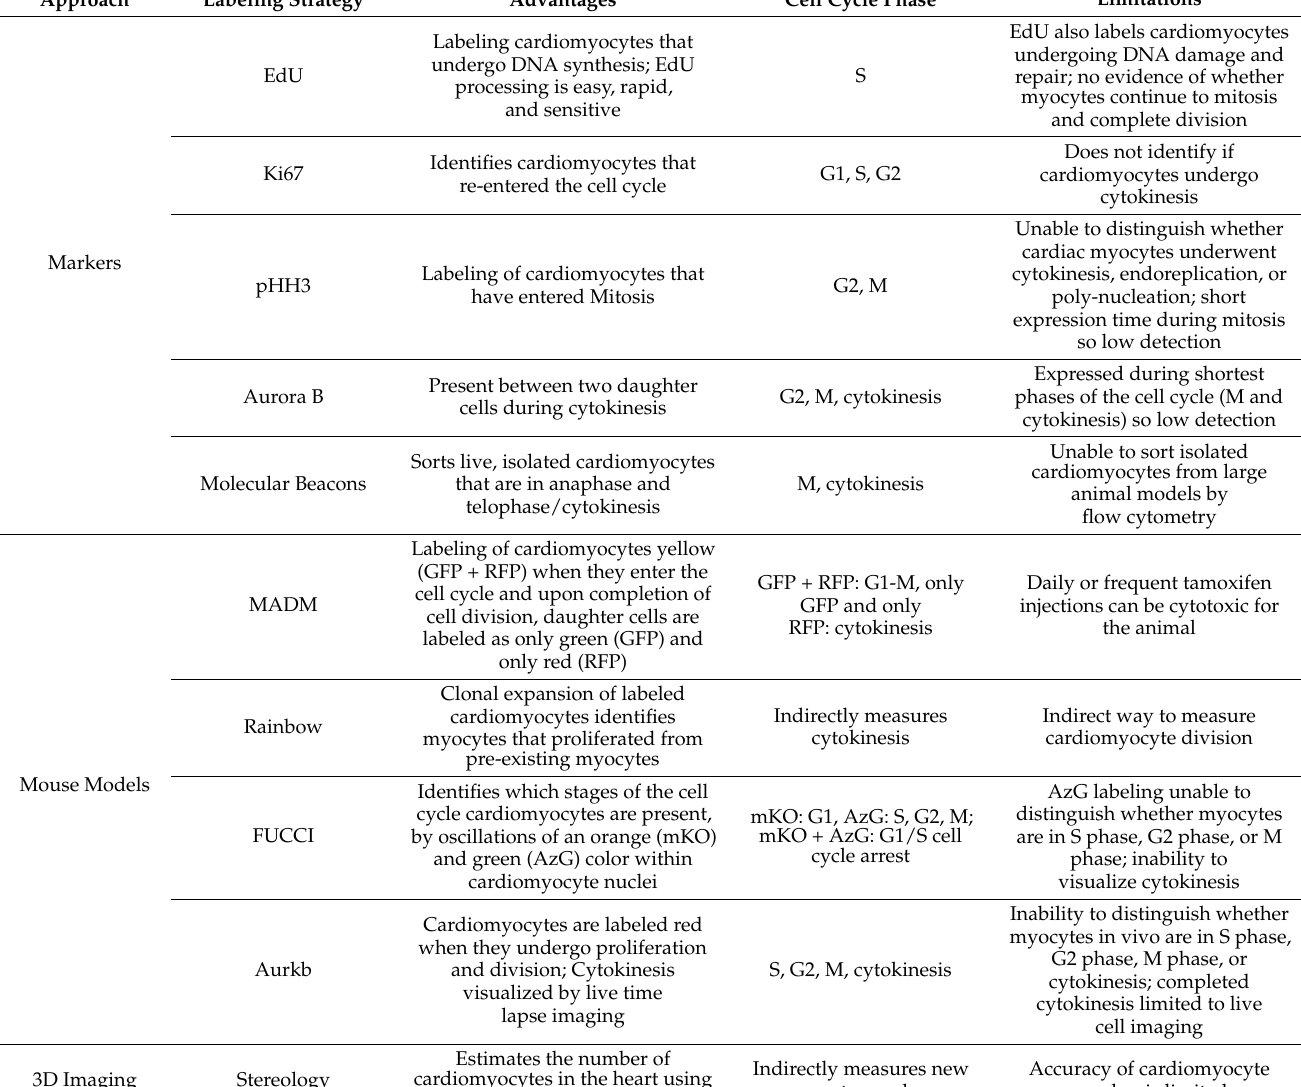
Table 2. Strategies to measure cardiomyocyte proliferation and